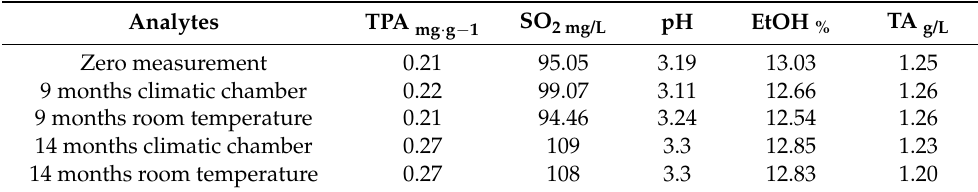
Table 7. Basic oenological parameters. Biologically active substances. Chardonnay. Basic oeno- logical parameters . Sample B—Chardonnay, harvest 2016.